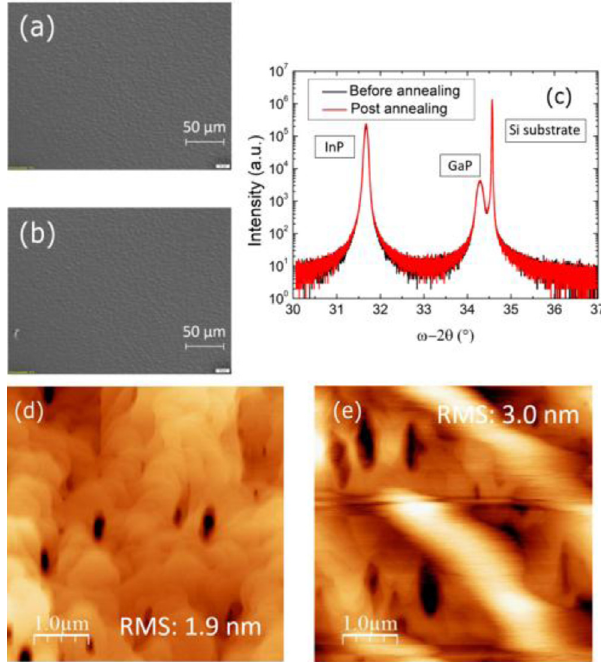
Fig. 5. NAsP sample before and after the 700 ° C annealing: morphology (a) before and (b) after from optical microscopy; (c) XRD diffractograms; AFM (d) before and (e) after.